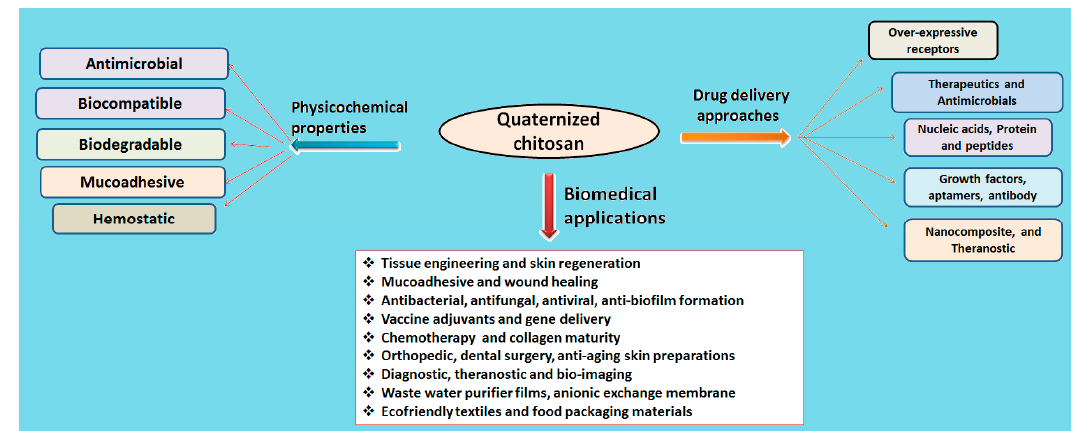
Figure 3. Quaternized chitosan and its physicochemical and drug delivery approaches.